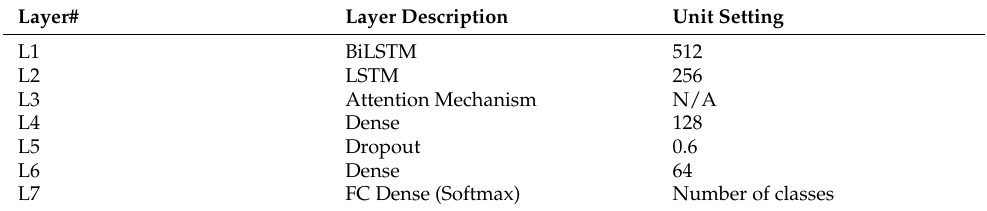
Table 6. Model 2—The proposed A-BiLSTM network architecture.